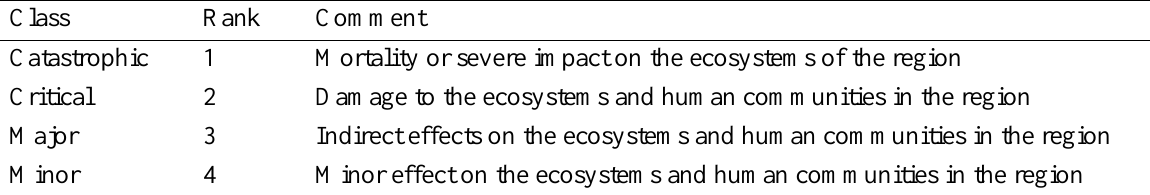
Table 1. Hazard severity in PHA (Halvani, 1998)